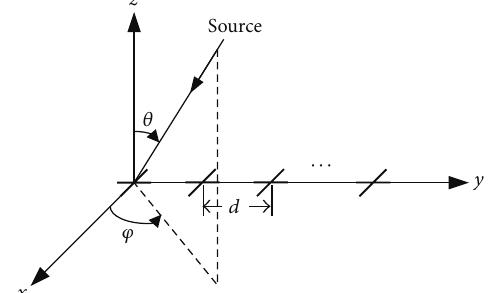
Figure 1: Uniform linear array of dual-polarization vector